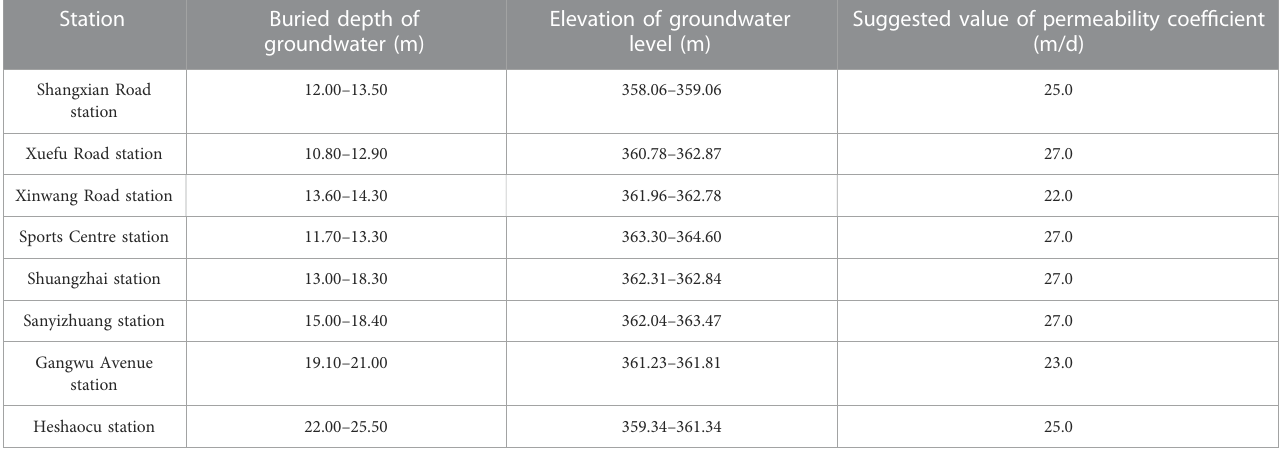
TABLE 1 Summary table of underground water depth and permeability coef fi cient of metro stations on Line 14. Station Buried depth of Elevation of groundwater groundwater (m) level